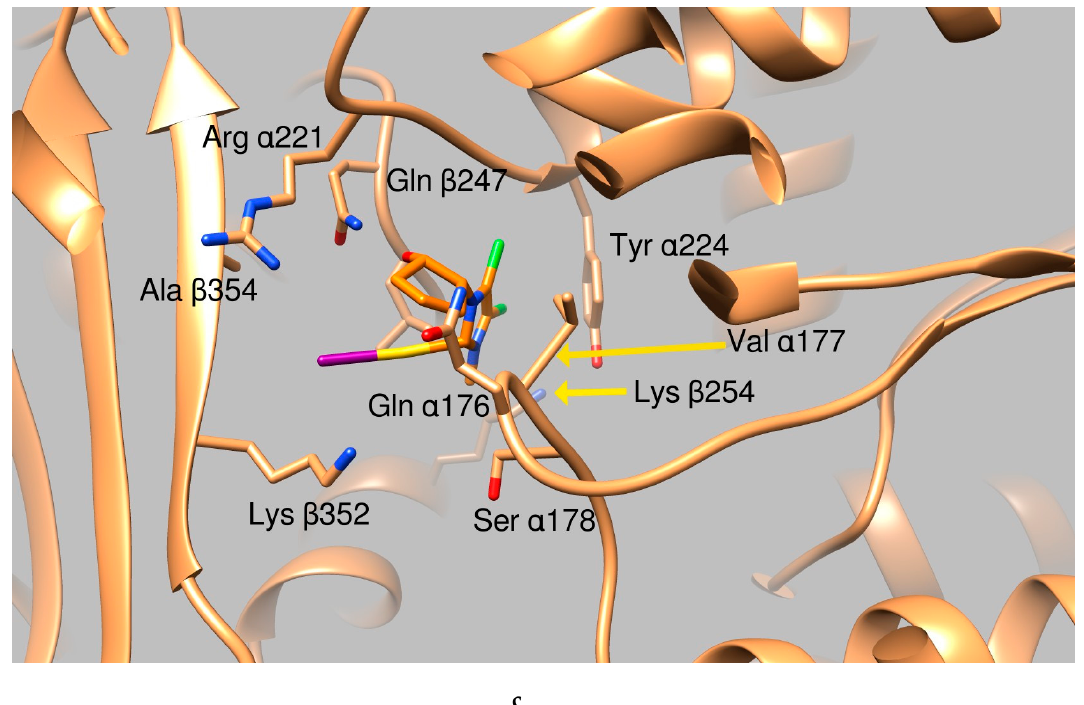
Figure 3. Graphical representation of AuL4 and AuL7 binding to the tubulin α : β interface. ( a ) Ribbon representation of the protein dimeric interface (tanned ribbons), bound ligands are reported as sticks. Residues involved in the binding are properly labeled. ( b ) Tubulin dimeric interface in complex with AuL7 (protein is represented in tanned ribbons, amino acids involved in ligand binding are properly labeled, AuL7 is drawn as purple sticks). ( c ) Close up of AuL4 (orange sticks) binding.